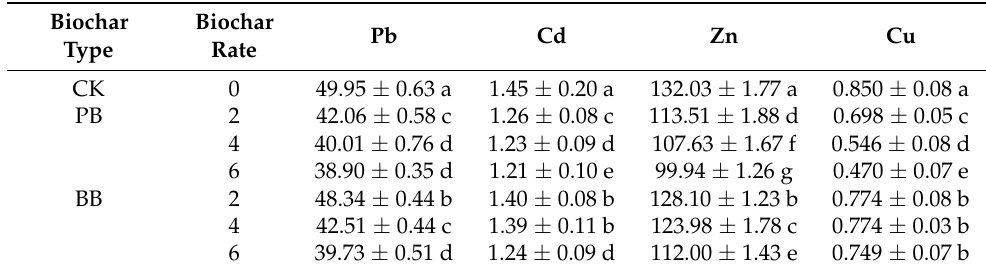
Table 3. Effects of biochar addition on concentration (mg kg − 1 ) of the TCLP-extractable metals in the contaminated